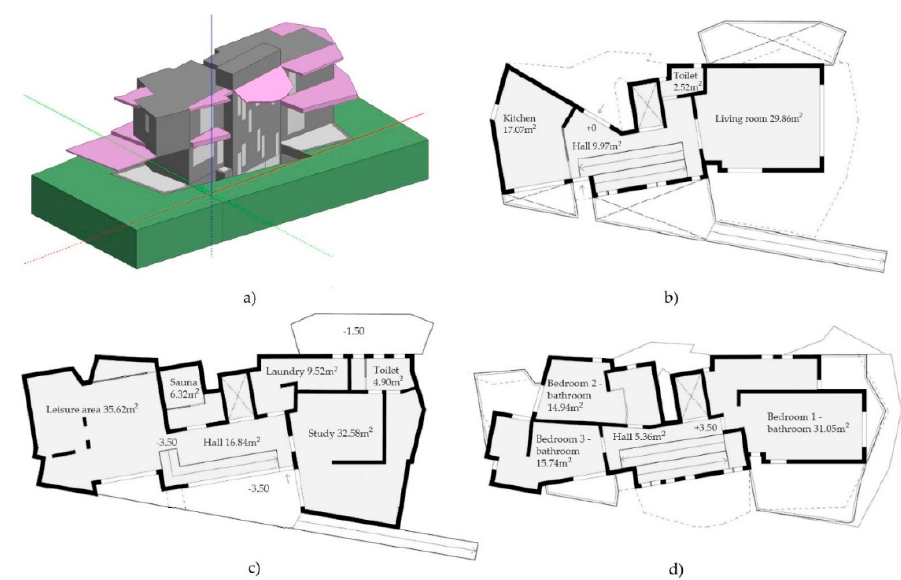
Figure 2. Case study. Building modeled in DesignBuilder TM : ( a ) 3D view, ( b ) Ground floor plan, ( c ) Basement level plan, ( d ) Upper floor plan.